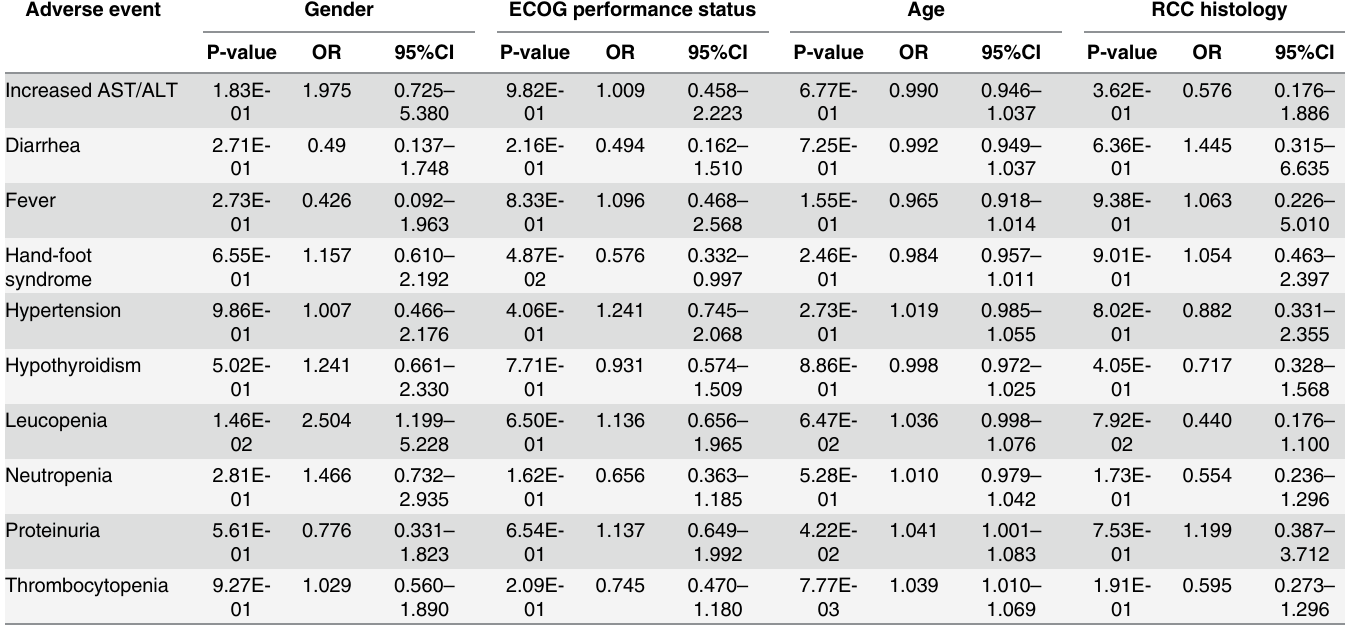
Table 2. Association of clinical variables with sunitinib-induced adverse